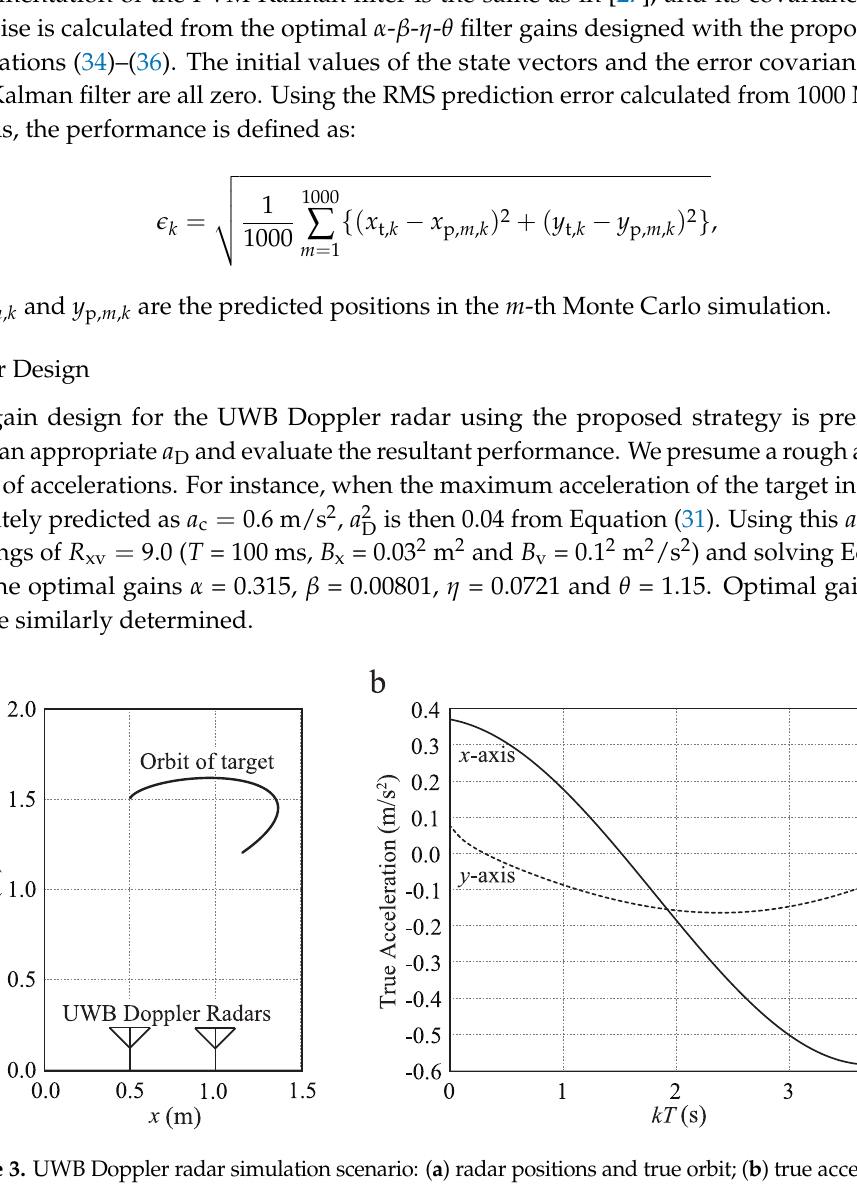
Figure 3. UWB Doppler radar simulation scenario: ( a ) radar positions and true orbit; ( b ) true acceleration; UWB: